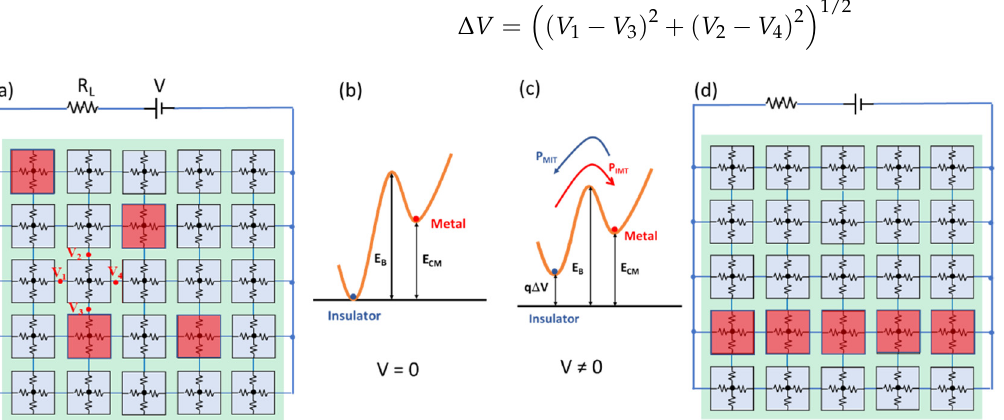
Figure 4. ( a ) Resistive network model of the VO 2 device under voltage bias used in the simulation. A few random pixels (light red) are shown in the metallic phase. Energy barriers for IMT and MIT without bias ( b ) and with bias ( c ). ( d ) A conducting filament formed between two electrodes, leading to an abrupt decrease in VO 2 device resistance. (after [41,42]).